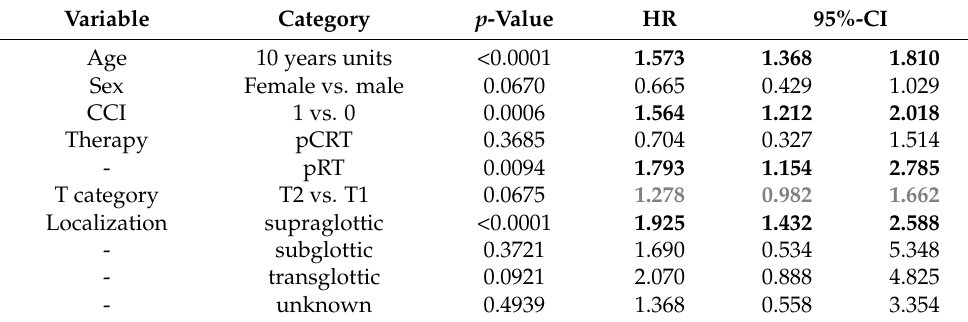
Table 3. Multivariable Cox regression analysis.